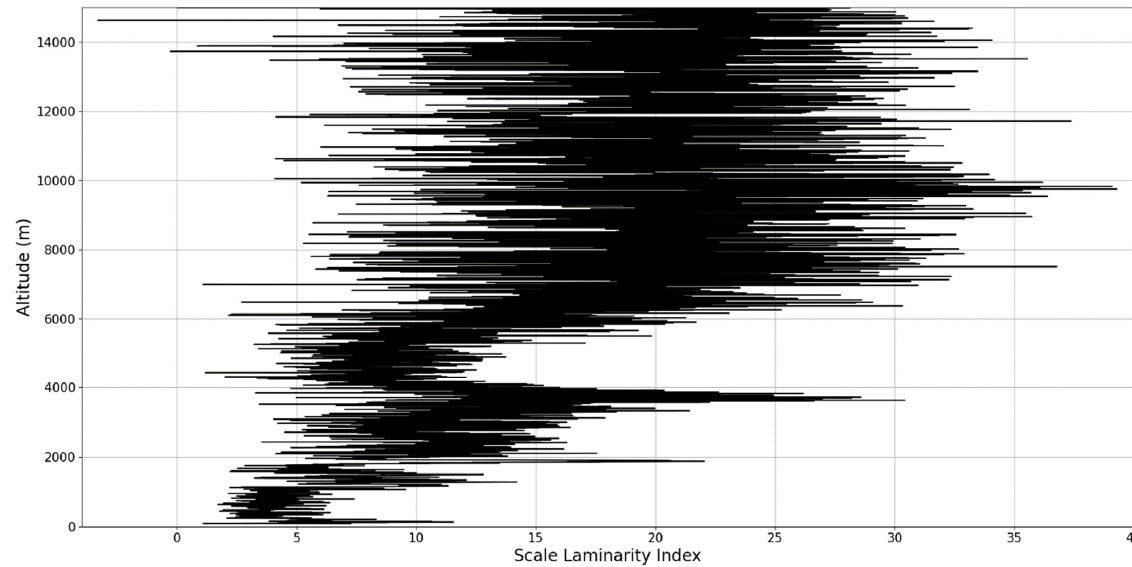
Figure 26. Scale laminarity index profile plot corresponding to point A.